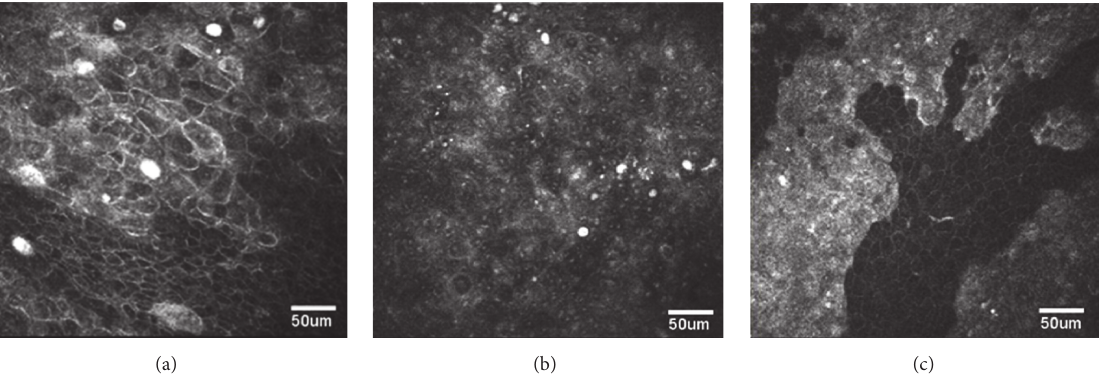
Figure 3: In vivo confocal microscopy findings of a patient with corneal/conjunctival intraepithelial neoplasia (CCIN). (a) demonstrates multinucleated bizarre-shaped cells in the mid-epithelial layer. In (b), a starry-sky pattern (ill-defined borders with tiny bright spots 2 to 4 𝜇 m in size within dark spaces) is seen in the basal cells. (c) demonstrates the fimbriated advancing border of CCIN at the mid-epithelial layer. There is higher reflectivity and cell density as well as pleomorphism in CCIN compared to the adjacent normal epithelium